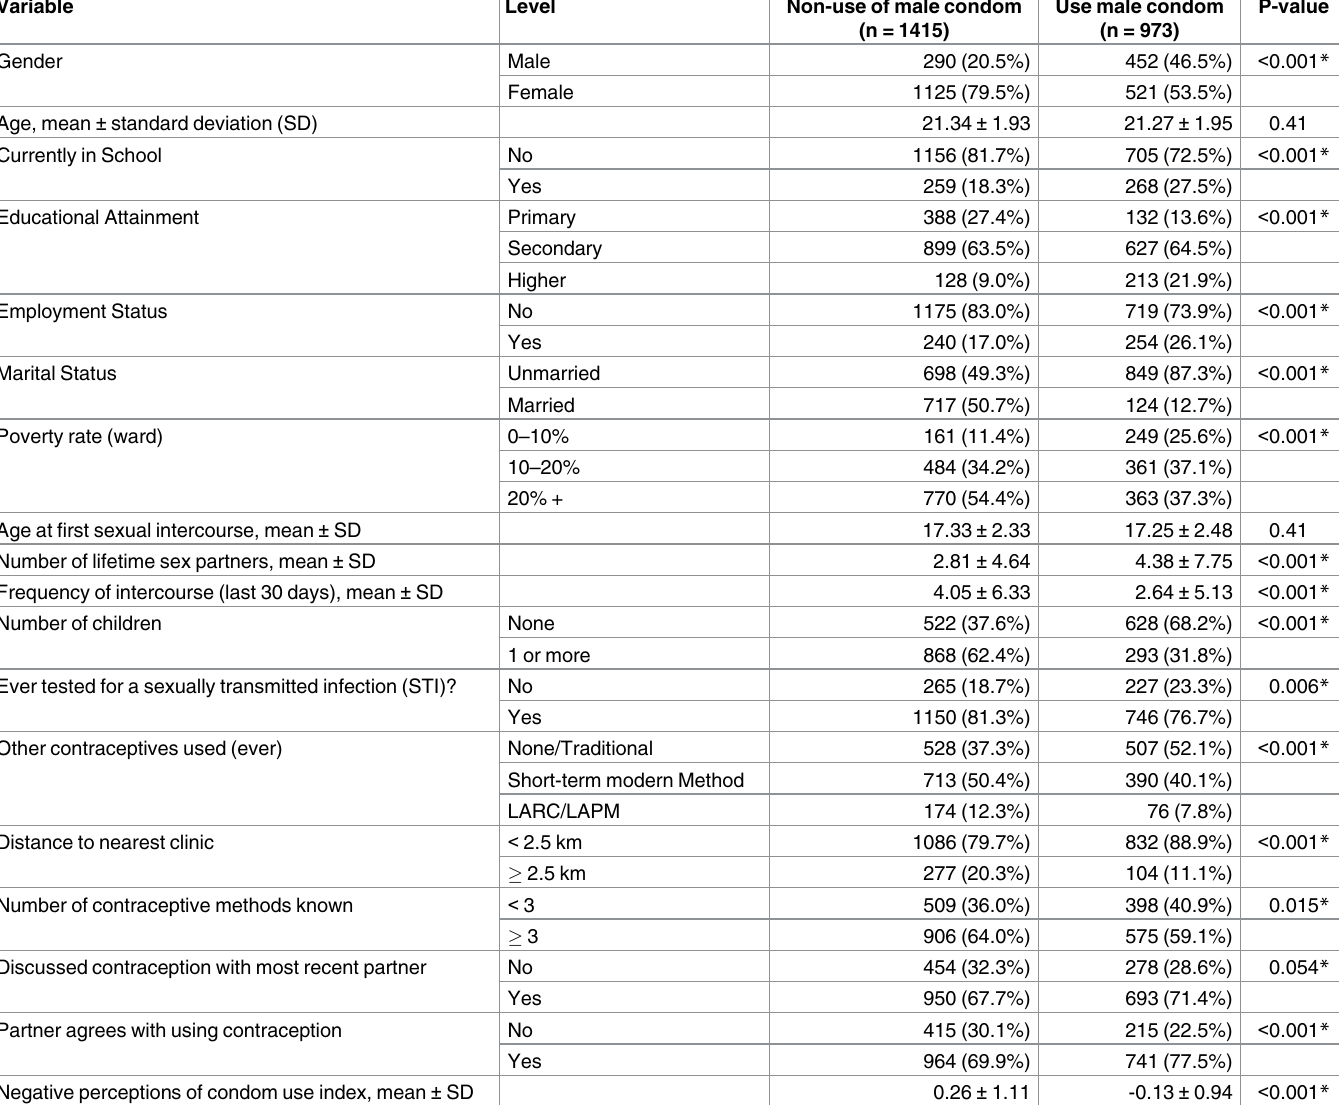
Table 1. Demographic and sexual health characteristics of participants by use and non-use of male condom at last sexual